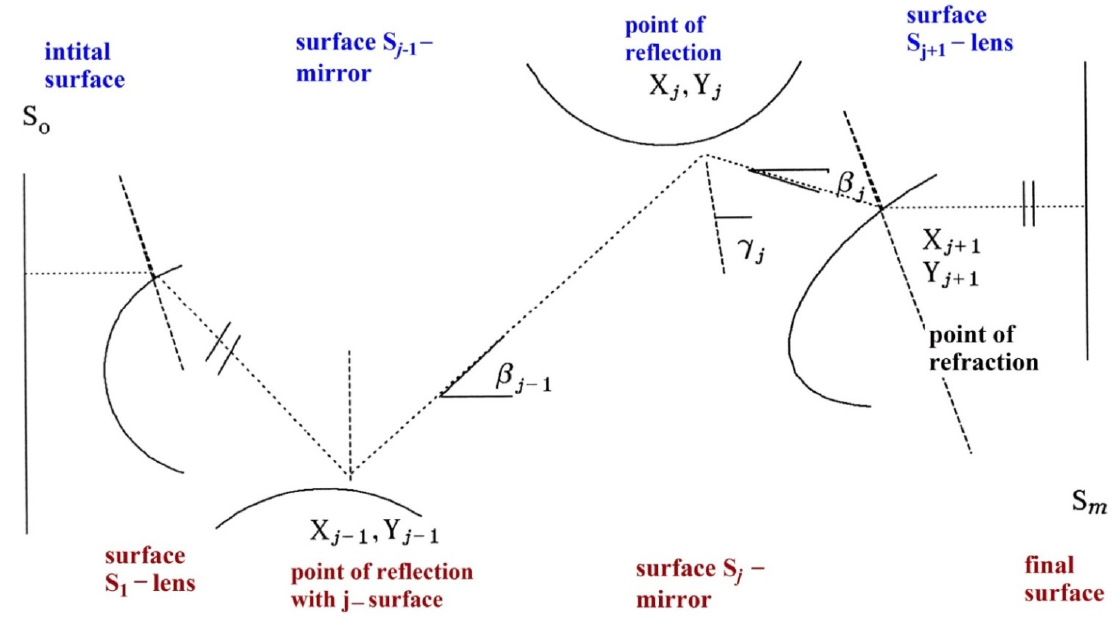
Figure 1. A graphic definition of rays and surfaces parameters.